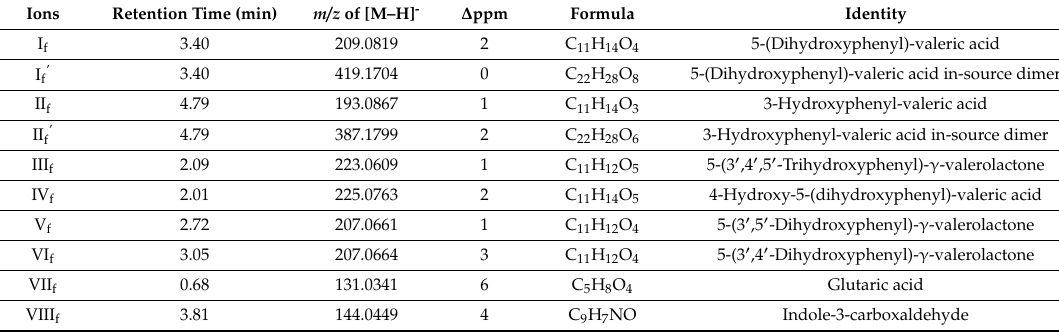
Figure 1. Identification of green tea polyphenol (GTP)-derived and GTP-responsive metabolites in human feces. ( A ) The scores plot from a PLS-DA model on 4 groups of human fecal samples, including P0, P12, T0, and T12. The t[1] and t[2] are the projection values of each sample in the first and second principal components of the model, respectively ( r 2 = 0.522 and q 2 = 0.126 for t[1]; r 2 = 0.234 and q 2 = 0.355 for t[2]). ( B ) The S-loadings plot of an OPLS-DA model on the comparison of T12 vs. P0, P12, and T0 fecal samples ( r 2 = 0.856 and q 2 = 0.521). Major ions contributing to the separation of T12 from P0, P12, and T0 samples are labeled. ( C – J ) Structure and MSMS spectra of I f - VIII f (Table 1). Table 1. Markers of GTP treatment in fecal metabolome. ∆ ppm: deviation of the measured mass from the theoretical mass in parts per million.